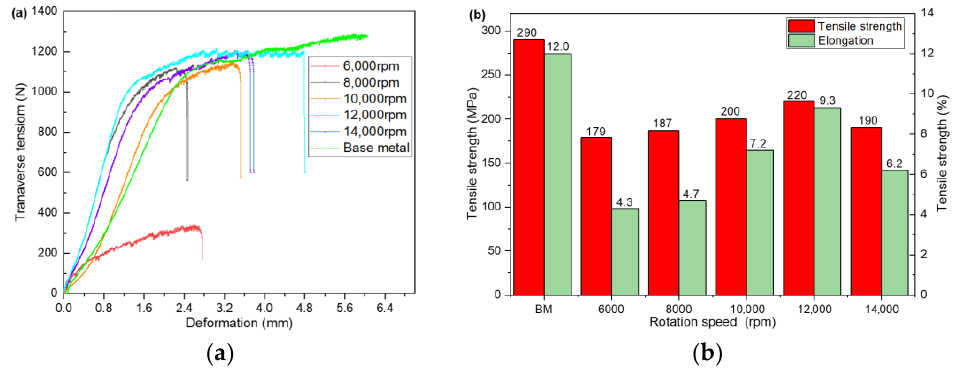
Figure 6. Variation of tensile strength and elongation of joint under different welding parameters, ( a ) The force – elongation curve, ( b ) Variation diagram of tensile strength and elongation.